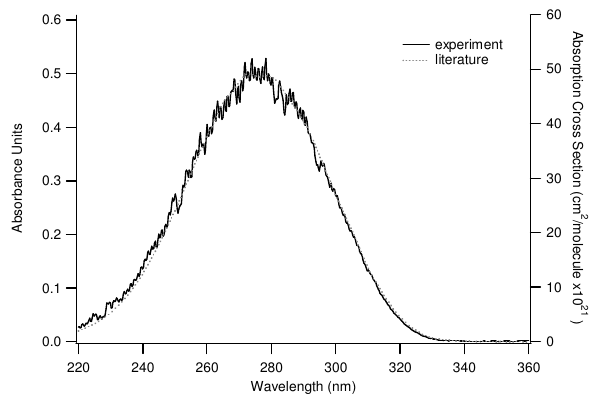
Figure 7. The extinction cross section spectrum measured by the AE-DOAS for 300 nm PSL is 2 Fig. 7. The extinction cross section spectrum measured by the AE- shown as solid black circles. The experimental error bars represent 1 σ of the mean. Mie theory 3 DOAS for 300nm PSL is shown as solid black circles. The experi- calculations are performed with various values for the RI. The result based on the constant 4 mental error bars represent 1 σ of the mean. Mie theory calculations manufacturer’s reported RI is shown as solid red diamonds, the RI derived from Ma et al. (2003) 5 are performed with various values for the RI. The result based on the based on the Cauchy coefficients is shown as solid green triangles and the French et al. (2007) 6 constant manufacturer’s reported RI is shown as solid red diamonds, experimentally determined CRI is solid blue squares. The experiment and calculations show 7 the RI derived from Ma et al. (2003) based on the Cauchy coeffi- improved convergence at wavelengths greater than 475 nm and are therefore not shown. 8 cients is shown as solid green triangles and the French et al. (2007) experimentally determined CRI is solid blue squares. The experi- ment and calculations show improved convergence at wavelengths greater than 475nm and are therefore not